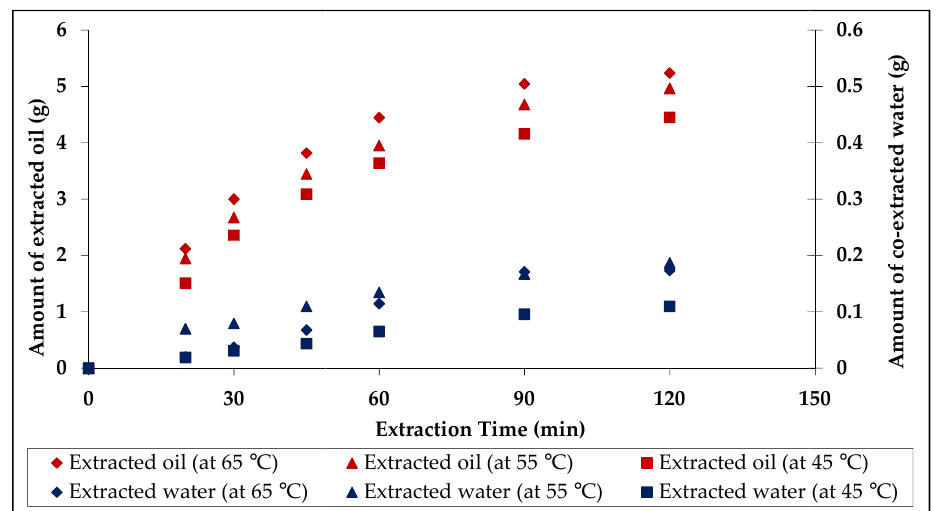
Figure 3. SCCO 2 extraction of oil and water at 300 bar, 35 kg h −1 kg −1 with 14.5 g of palm mesocarp.